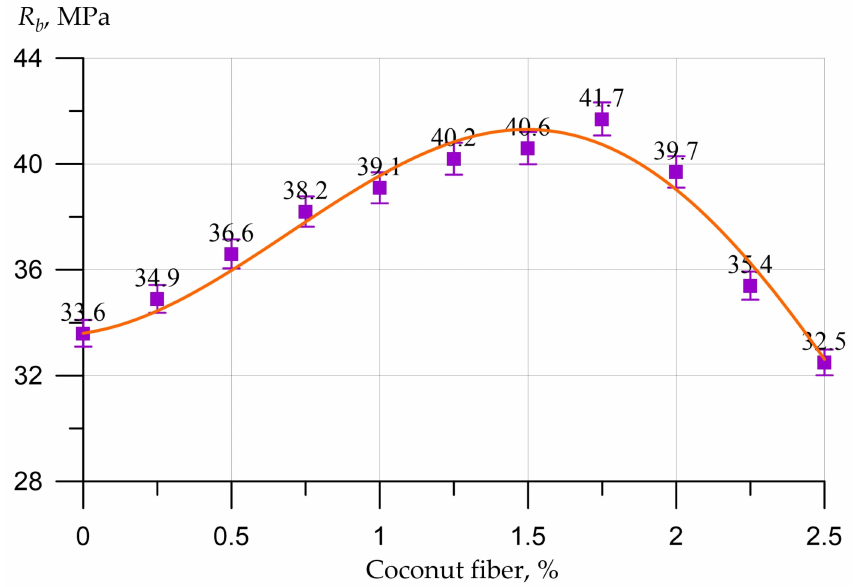
Figure 8. Dependence of the axial compressive strength ( R b ) of prism concrete samples with dimen- sions of 100 × 100 × 400 (mm) on the percentage of coconut